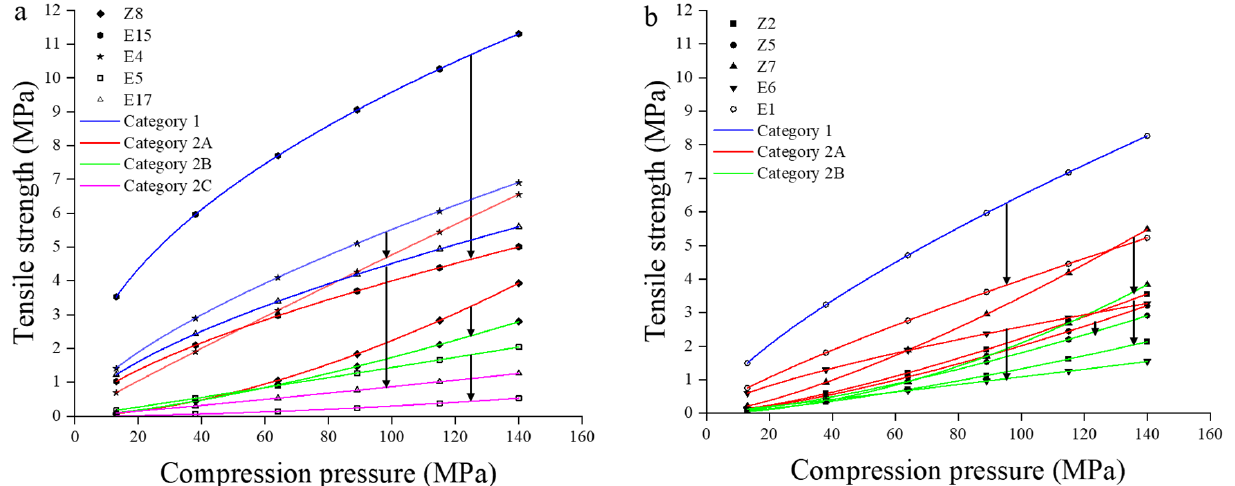
Figure 6. The change of tabletability for 10 materials. ( a ) the change of tabletability for 5 materials (Bistortae Rhizoma (No. Z8), maltodextrin (No. E4), pregelatinized starch (No. E5), MCC PH101 (No. E15), L-HPC (No. E17)); ( b ) the change of tabletability for 5 materials (Angelicae sinensis Radix (No. Z2), Bran-Processed Atractylodis Rhizoma (No. Z5), Chuanxiong Rhizoma (No. Z7), cold water-insoluble starch (No. E1), Lactose Flowlac 100 (No. E6)).